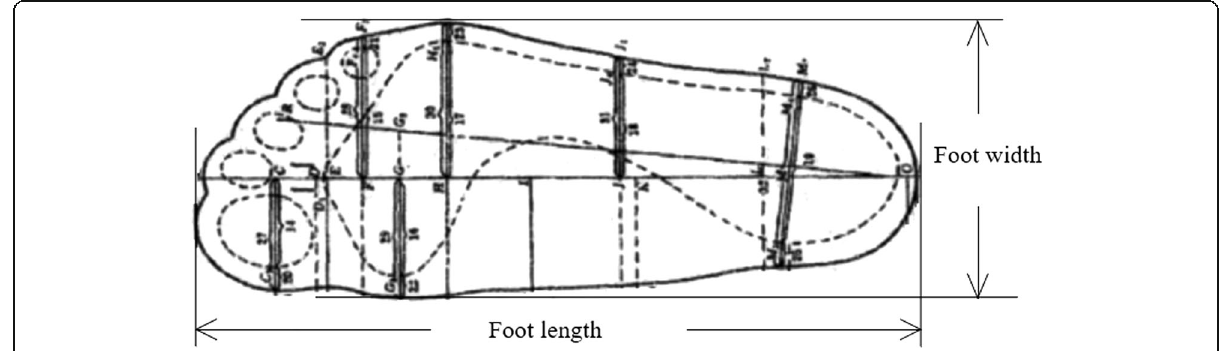
Fig. 6 Foot length and width measurement of the